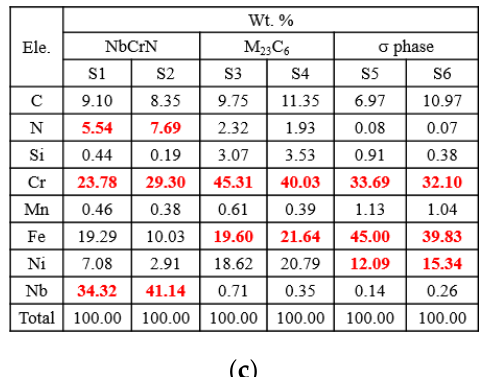
Figure 4. EDS analysis of precipitates in the 700 °C/90 MPa/9411 h crept specimen: ( a ) SEM micro- graphs in the near-fracture region, ( b ) the corresponding spectrum of site 1 (S1) and ( c ) EDS results of S1~S6 in ( a ) with red letters for major elements.